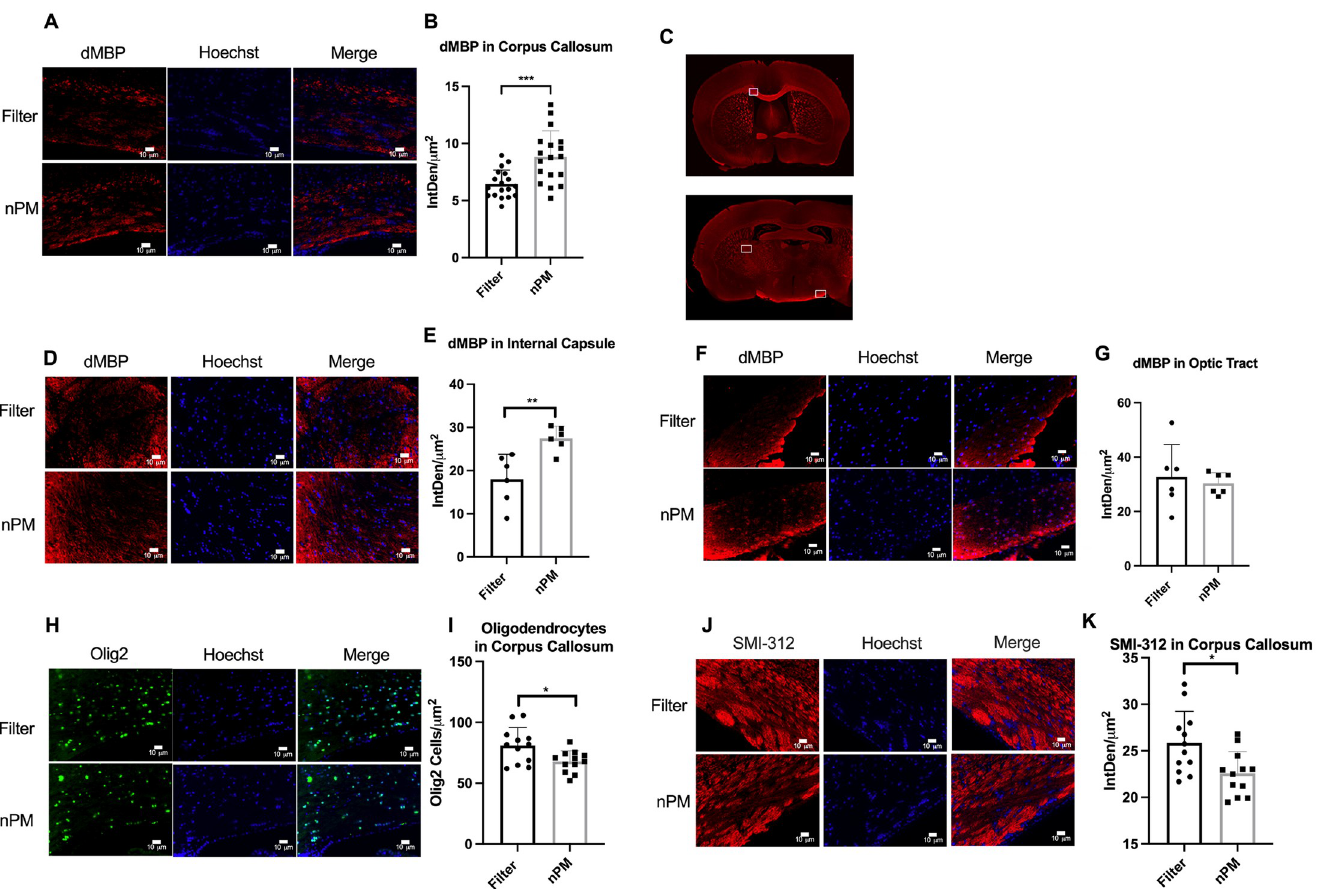
Fig 2. nPM exposure results in myelin injury and axonal damage in the corpus callosum. (A) dMBP in the corpus callosum of mice exposed to filtered air and nPM. Analysis was performed on both right/left sides. Right side location is marked in C. (B) dMBP immunofluorescent density was significantly increased in the corpus callosum of mice exposed to nPM (n = 18) compared to filtered air (n = 18) (p < 0.001). (C) Representative images of regions analyzed (Top: Right side corpus callosum is marked. Bottom: Right side internal capsule and left side optic tracts are marked). Analysis was performed on both right and left sides. (D) dMBP in the internal capsule of mice exposed to filtered air and nPM. Analysis was performed on both right/left sides. Right side location is marked in C. (E) dMBP immunofluorescent density was significantly increased in the internal capsule of mice exposed to nPM (n = 6) compared to filtered air (n = 6) (p < 0.01). (F) dMBP in the optic tract of mice exposed to filtered air and nPM. Analysis was performed on both right/left sides. Left side location is marked in C. (G) dMBP immunofluorescent density was not significantly different in the optic tract of mice exposed to nPM (n = 6) compared to filtered air (n = 6) (p = 0.65). (H) Oligodendrocytes in the corpus callosum of mice exposed to filtered air and nPM. (I) Oligodendrocyte cell counts were significantly decreased in the corpus callosum of mice exposed to nPM (n = 12) compared to filtered air (n = 12) (p < 0.05). (J) SMI-312 in the corpus callosum of mice exposed to filtered air and nPM. Analysis was performed on both right/left sides. (K) SMI- 312 immunofluorescent density was significantly decreased in the corpus callosum of mice exposed to nPM (n = 12) compared to filtered air (n = 12) (p < 0.05). Data presented as mean ± standard deviation. Scale bars represent 10 μ m. Error bars represent standard deviation. � signifies p < 0.05, �� signifies p < 0.01, ��� signifies p <